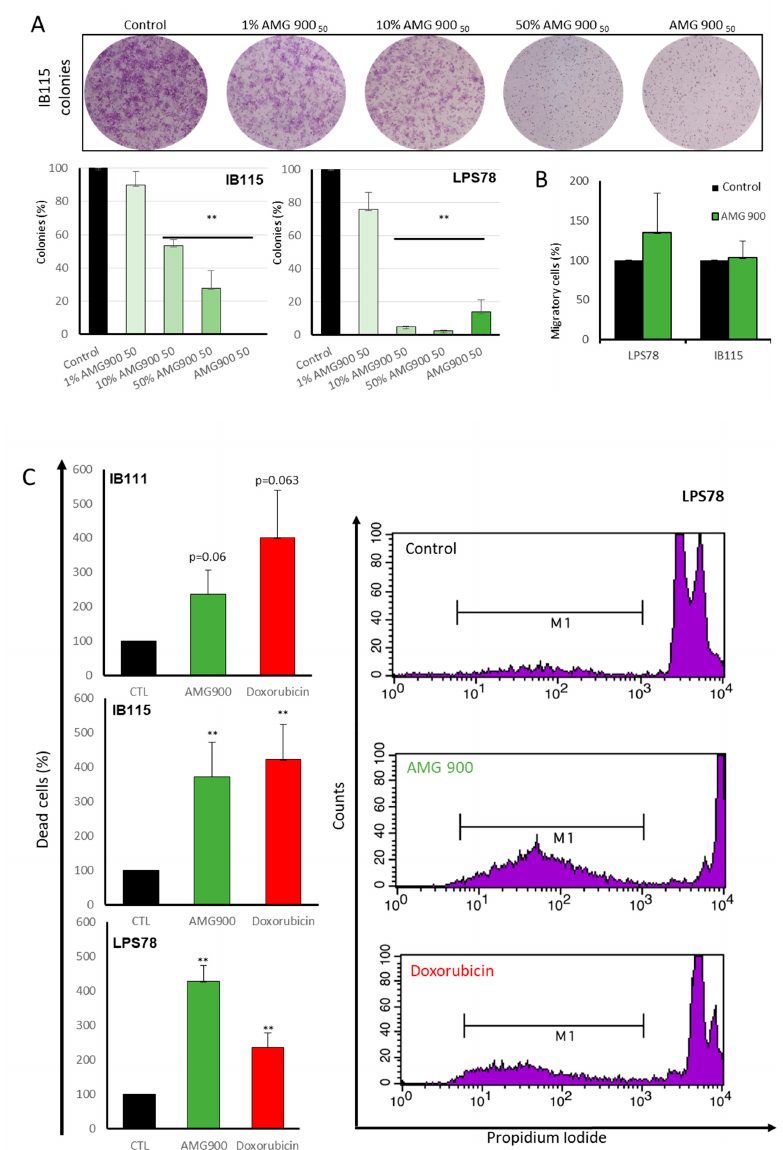
Figure 5. AMG 900 impairs clonogenicity and induces apoptosis di ff erently in LPS. (A ) Clonogenicity in two di ff erent LPS cell lines. Cell are plated at low density and treated for 24H with di ff erent percentage of AMG 900 IC 50 and clones are counted after crystal violet coloration at 8 days of treatment. Histograms are mean values of triplicate +/ − SEM. ( B ) Migration in LPS78 and IB115 cells. Cells were plated with serum free medium in a transwell and dive into serum containing medium ( +/ − AMG900) for 24H before crystal violet coloration and counting. ( C ) Apoptosis and necrosis induce by AMG 900 or doxorubicin in three di ff erent LPS cell lines. Cells are treated for 72H before analysis. Apoptosis was determined by flow cytometry quantification of cell lines PI labelled. Histograms are mean values of triplicate +/ − SEM (**: p <